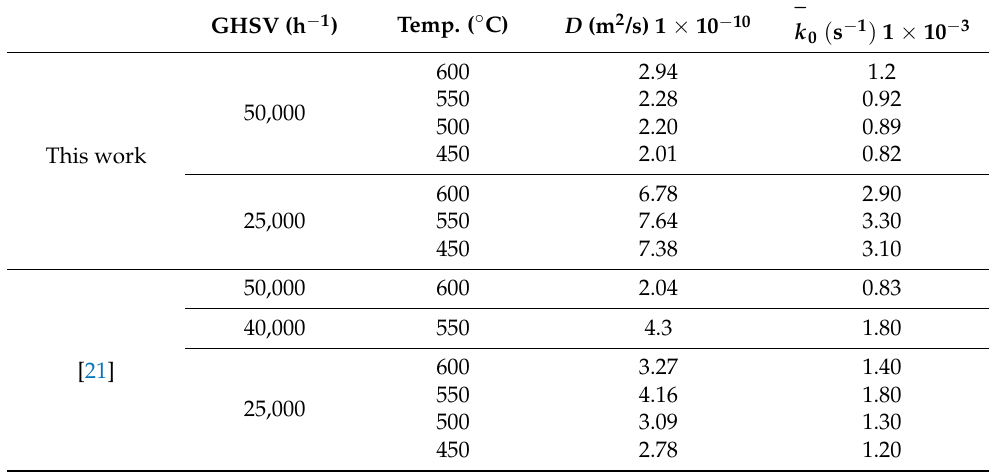
Table 11. Kinetic reaction parameters and diffusion coefficients using a spherical geometry